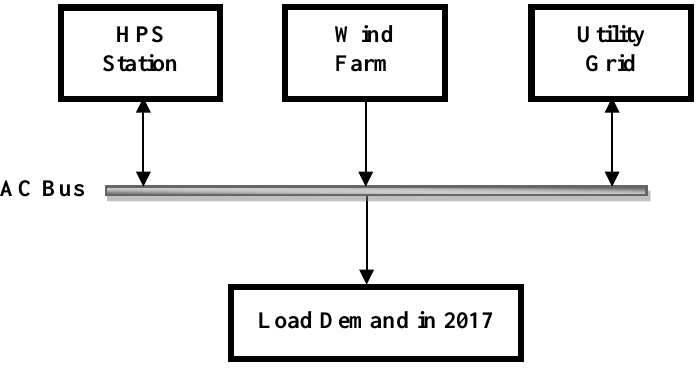
Figure 1. On-grid hydro–wind energy schematic.